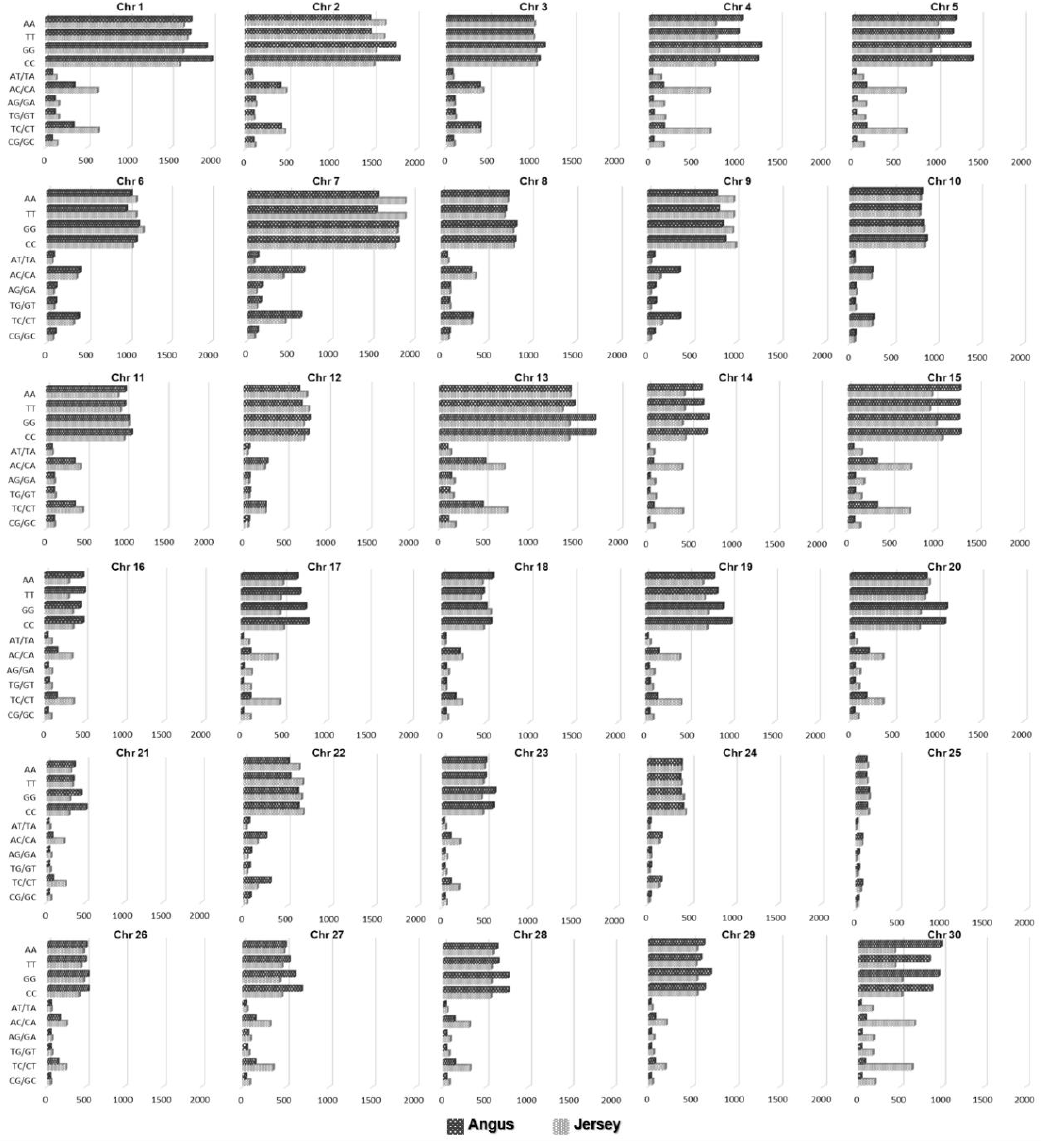
Figure 2. Distributions of the SNPs identified by conditional mutual information (CMI) distinguishing between Angus and Jersey on each chromosome. Patterned black and grey bars indicate the numbers of SNPs identified by CMI in Angus and Jersey according to the genotypes of SNPs on each chromosome. For all graphs, the x -axis is the number of SNPs, and the y -axis represents the genotypes of SNPs (AA, TT, GG, CC, AT/TA, AG/GA, AC/CA, TG/GT, TC/CT, and GC/CG).